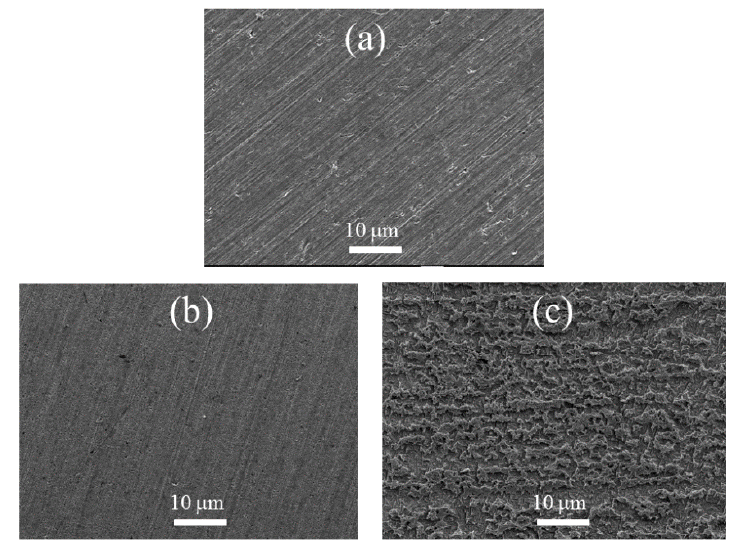
Figure 7. Surface feature of copper in the different condition: ( a ) the surface of the copper after the sanding, ( b ) the copper after the addition of the inhibitor molecule is immersed in 298 K at 0.5 mol/L H 2 SO 4 for 24 h, and ( c ) copper surface after soaking for 24 h in 0.5 mol/L H 2 SO 4 in 298 K.